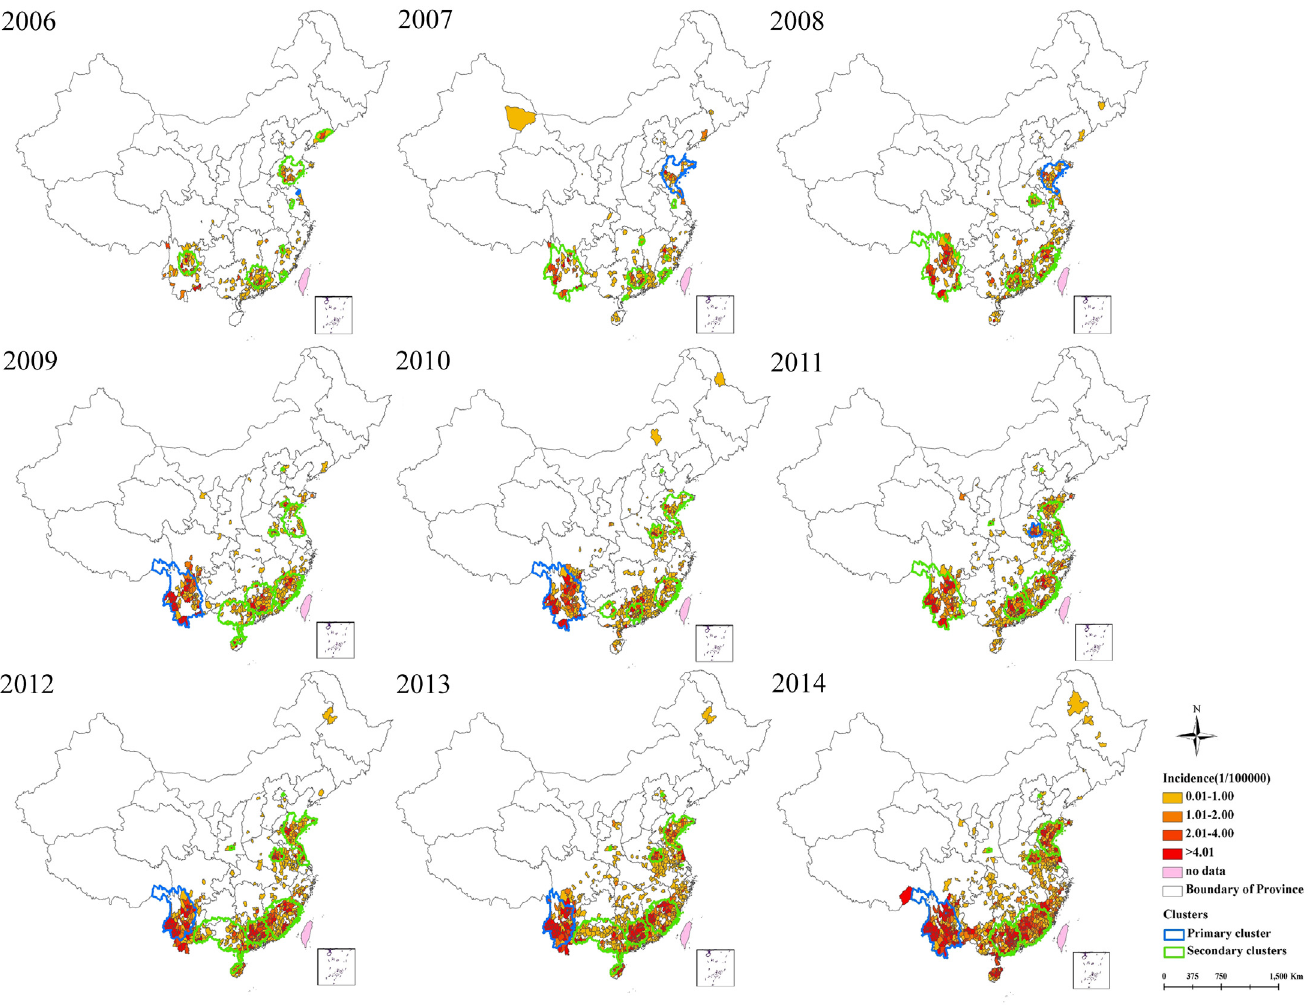
Fig 4. Yearly spatiotemporal clusters overlay with annual incidence of scrub typhus in mainland China, 2006 – 2014. Yearly spatiotemporal clusters were detected using a circular scan window with the maximum spatial size of 5% of the population at risk and a maximum temporal size of 10% of the study